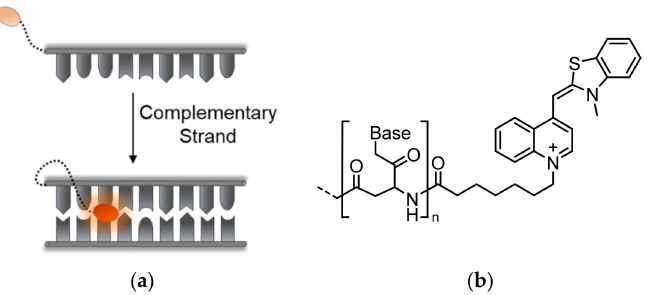
Figure 3. Light-Up probes. ( a ) The operating mechanism of Light-Up probes: upon hybridization to a target sequence, TO (orange oval) intercalates within the formed duplex and displays increased fluorescence; ( b ) the general chemical structure of PNA-based Light-Up